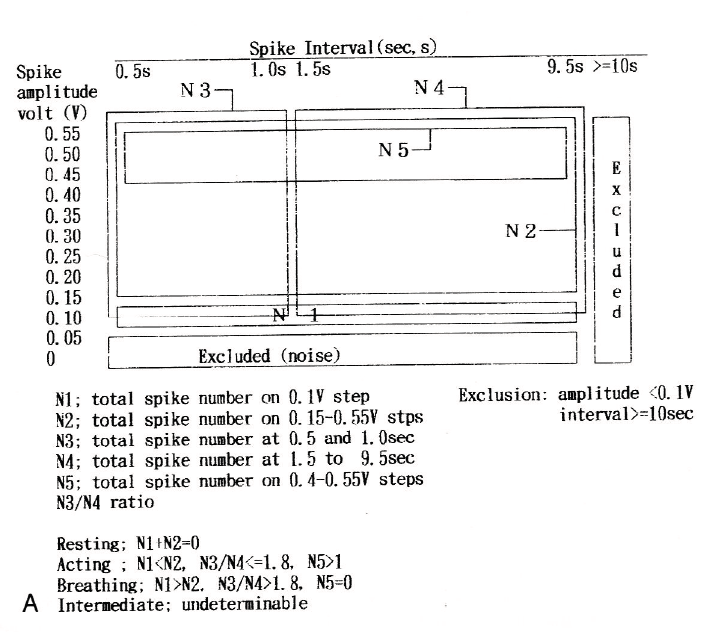
Figure 3. The algorithm to automatically define fetal behavioral states into active and resting states. Undeterminable state was intermediate fetal state